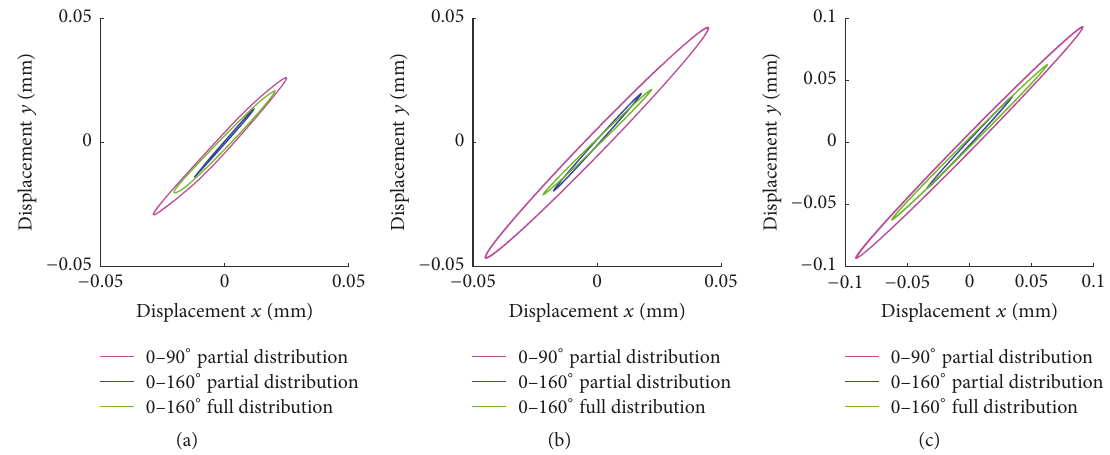
Figure 6: Shaft center orbits ( 𝑦 versus 𝑥 ): (a) 1000r/min; (b) 2800 r/min; (c) 3600